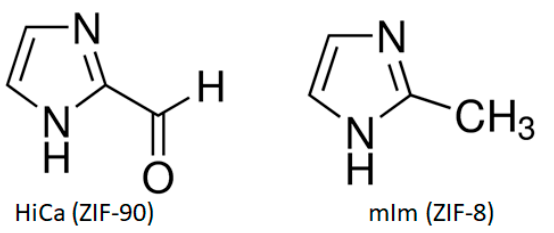
Figure 6. Showing linkers for ZIF-90 (HiCa) and ZIF-8